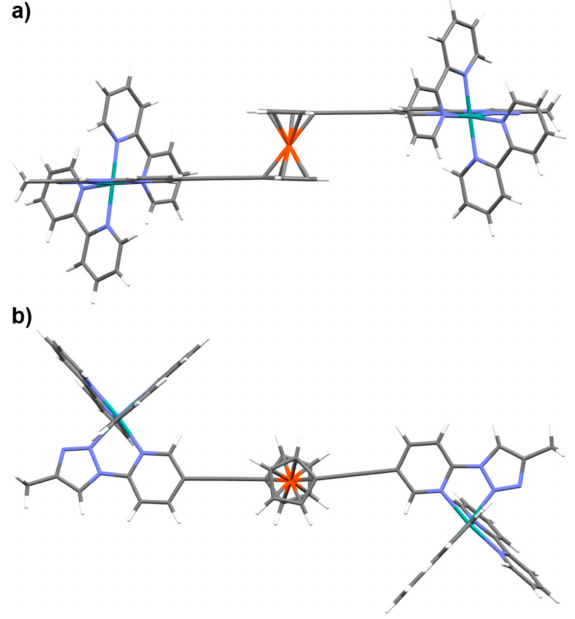
Figure 5. Density Functional Theory (DFT) (CAM-B3LYP, 6-31G(d)) optimised structure of L4Ru (dihedral ≈ 180 ◦ ) with ( a ) side view and ( b ) top